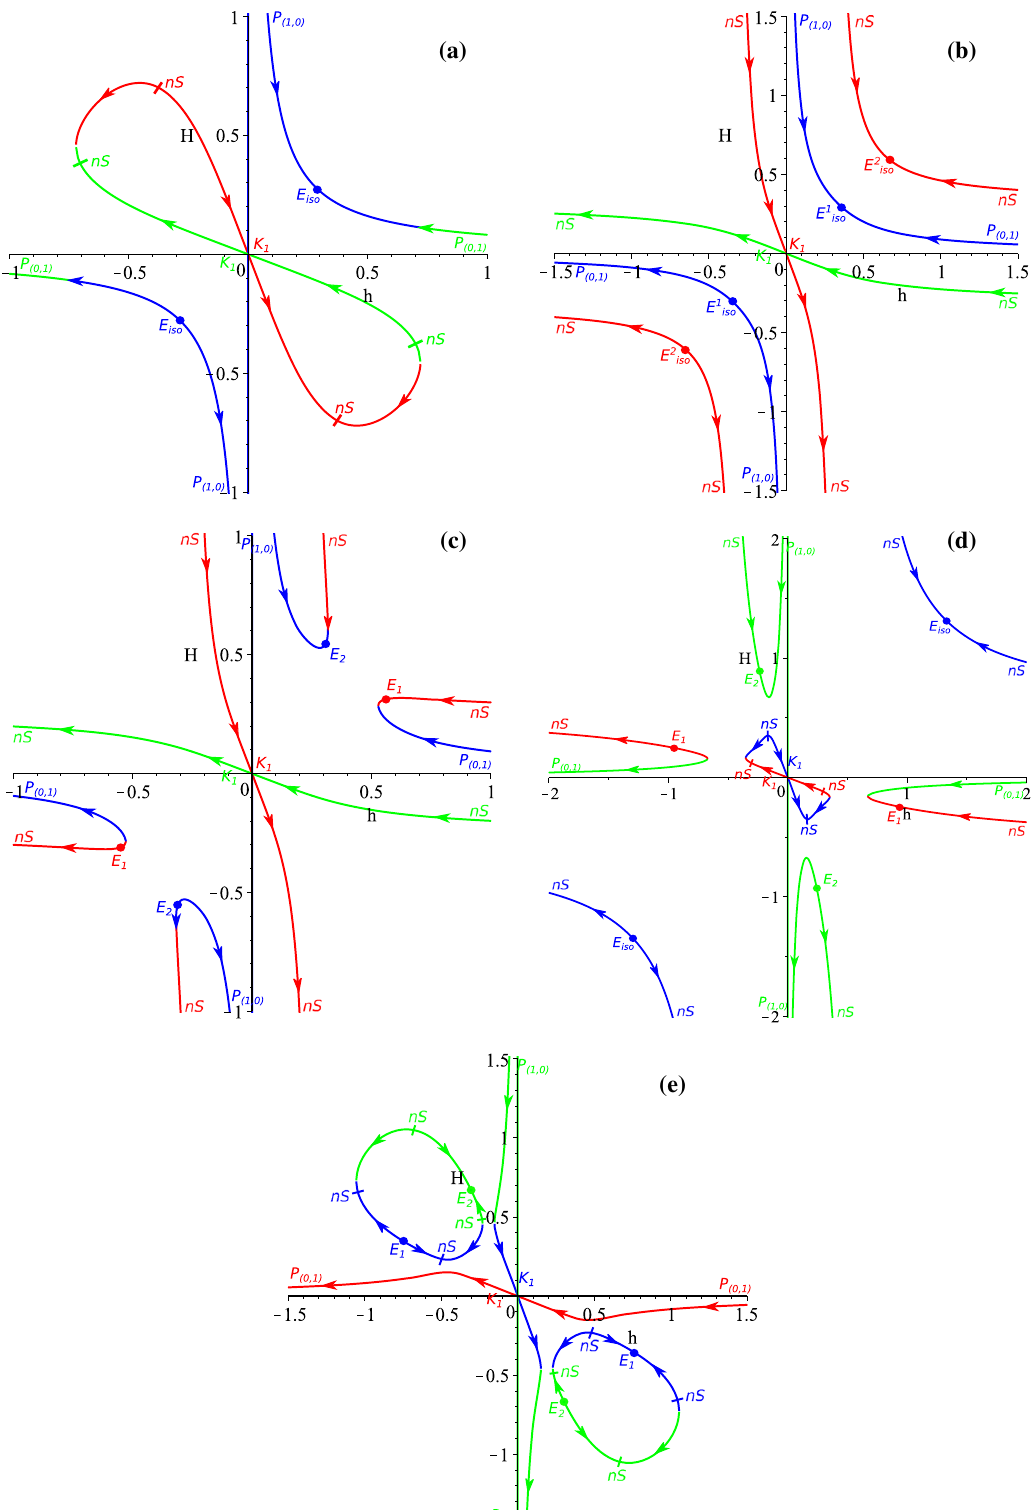
Fig. 8 Final compilations of all possible regimes in D = 3 vacuum cubic Lovelock case, on H ( h ) evolution curves; different colors corre- spond to three different branches H 1 , H 2 and H 3 ; panels layout is